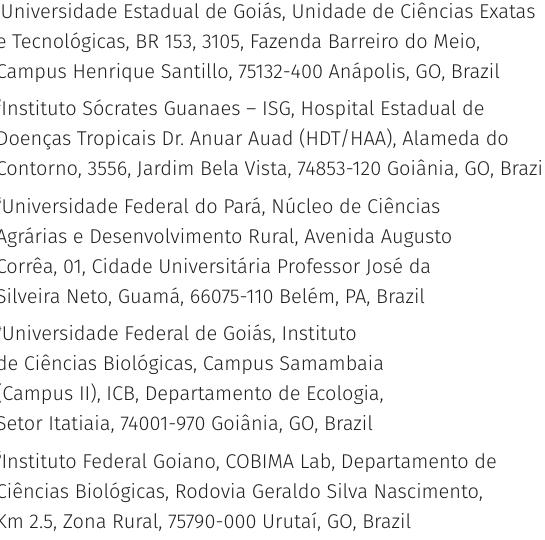
Figure S1. Answers given by students from municipality with a CU facility and municipality without a CU facility to the questions a) 6 and b) 7 of the subjective/ descriptive questionnaire. Question 6 referred to the frequency of the students’ contact with nature, and question 7 referred to locations where the students have field classes in both municipalities. Table SI. The species utilized in our questionnaires considering their scientific names, popular names, taxonomic group, and status (native or exotic) in Brazil. Quantitative Questionnaire